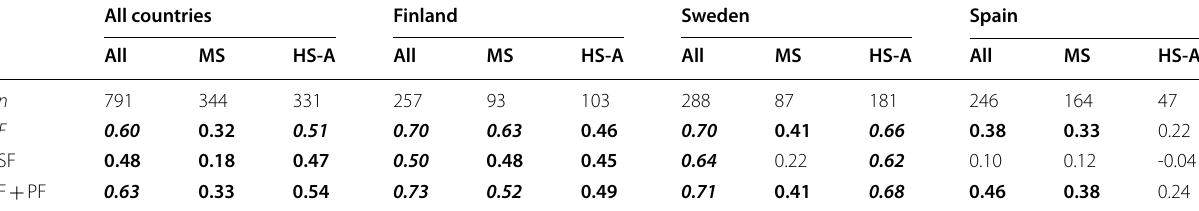
Bolded correlations are statistically significant at the p < 0.0001 level. Correlations above 0.5 are in bold italics There were too few students in the high school basic tracks (HS-B) to calculate reliable correlations, but these students are included in the “All” columns. Note that the averages over countries are not weighted by the number of students in the different groups MS middle school; HS-A advanced mathematics track high school; F flexibility; SF spontaneous flexibility; PF potential flexibility